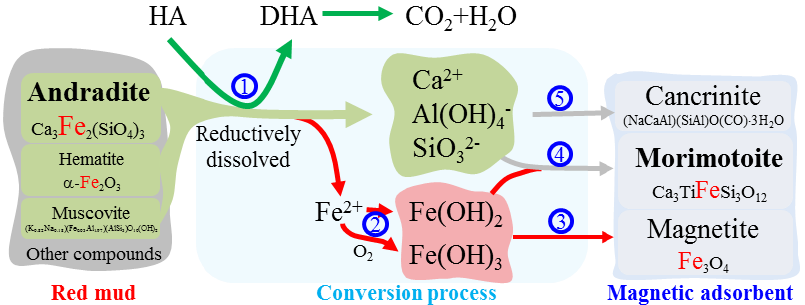
Figure 4. The proposed conversion route of iron mud into magnetic adsorbent. Step 1 represents the reductive dissolution of red mud; Step 2 represents the oxidization of ferrous Fe; Steps 3 to 5 represent the crystallization of magnetite, morimotoite, and cancrinite,